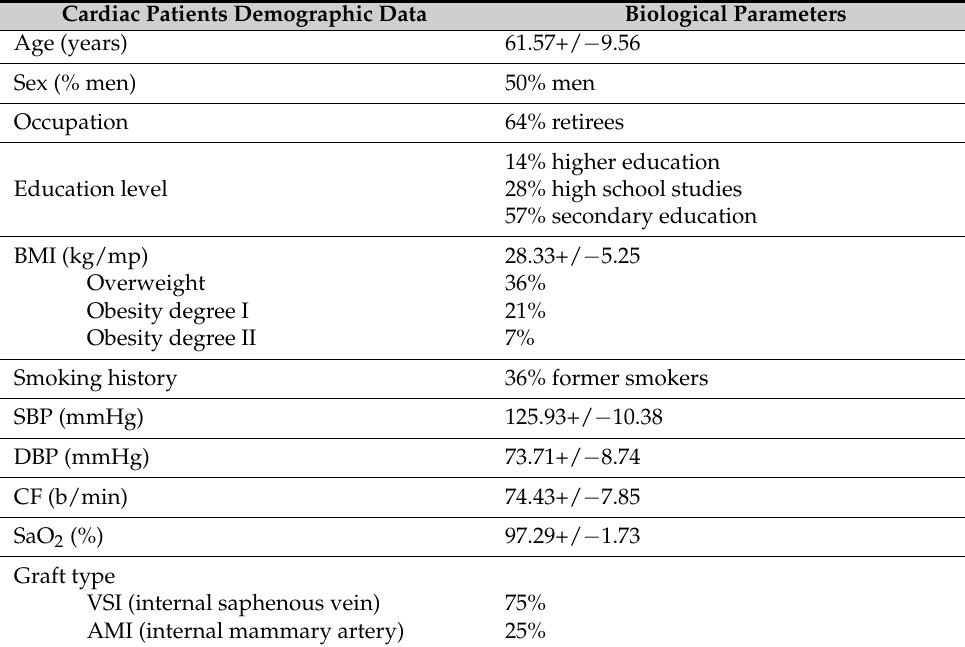
Table 6. Biological parameters of the selected cardiac patients.